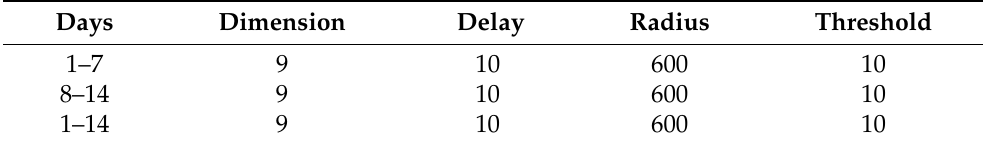
Table 14. Best parameters for